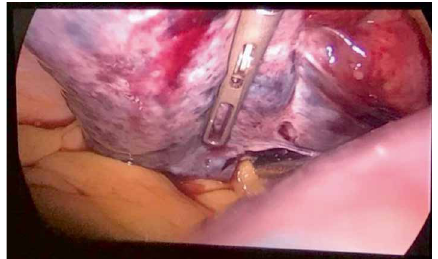
Figure 4: Complete return of blood flow to the left